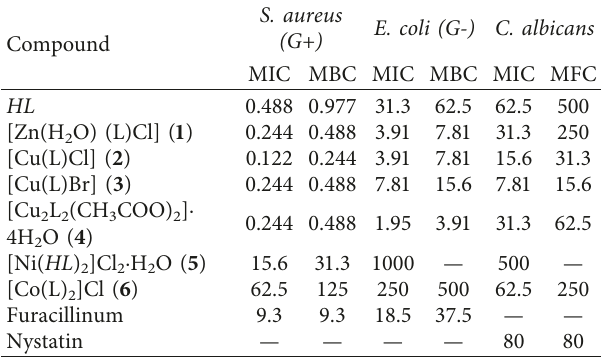
Table 6: Antibacterial and antifungal activities of HL thio- semicarbazone and copper complexes 1 – 6 as MIC a /MBC b /MFC c values ( μ g/mL).